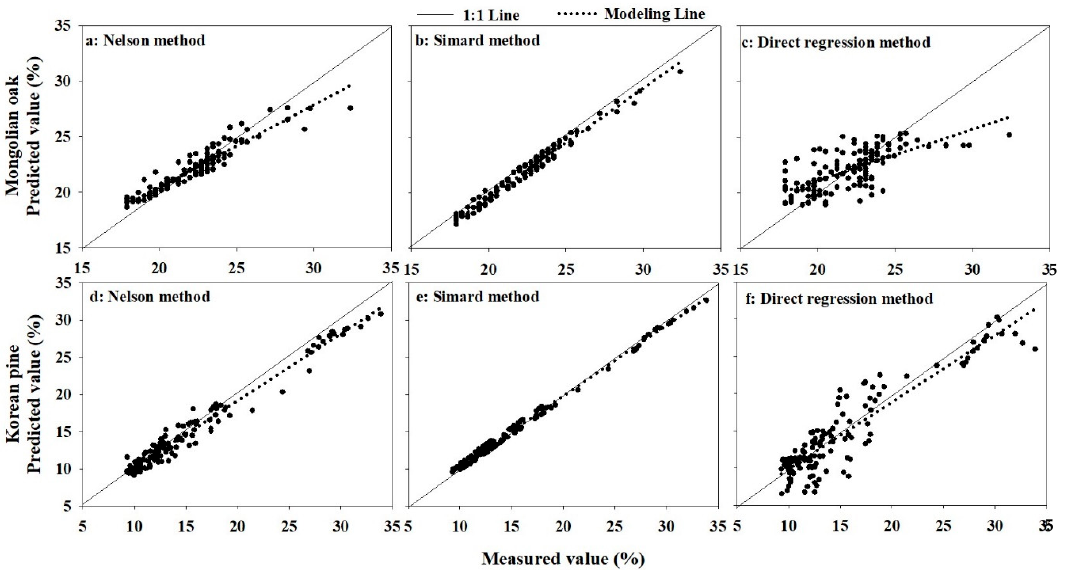
Figure 7. Comparisons of measured and predicted values. ( a – c ) indicate the comparisons of measure and predicted values of Mongolian oak by Nelson, Simard and Direct regression methods, respectively; ( d – f ) indicates the comparisons of measure and predicted values of Korean pine by Nelson, Simard and Direct regression methods, respectively.